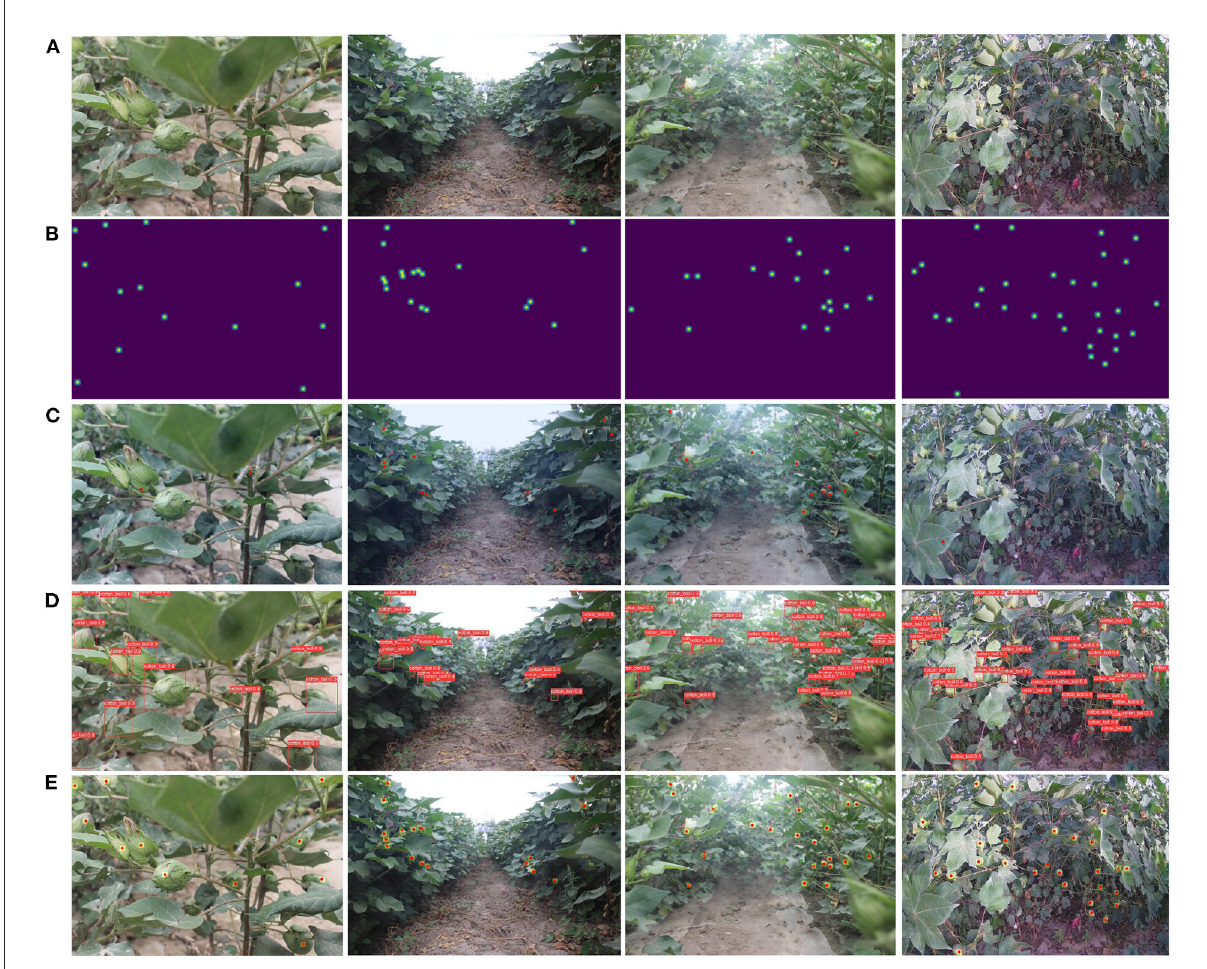
FIGURE7 Localization effect of three methods in different density images. (A) Is original image and (B) is ground-truth. (C–E) Are the localization effects of MSPSNet, YOLOv3-spp, and MCBLNet, respectively.